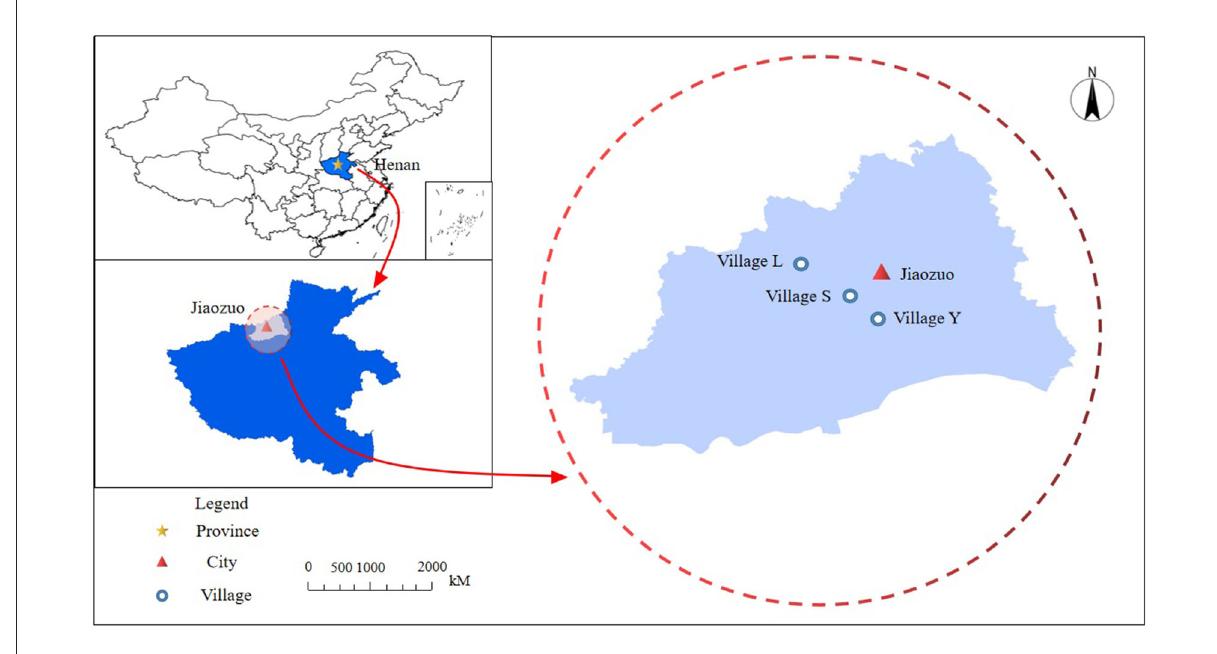
FIGURE2 Location of the target areas: Village S, Village Y, Village L, China.